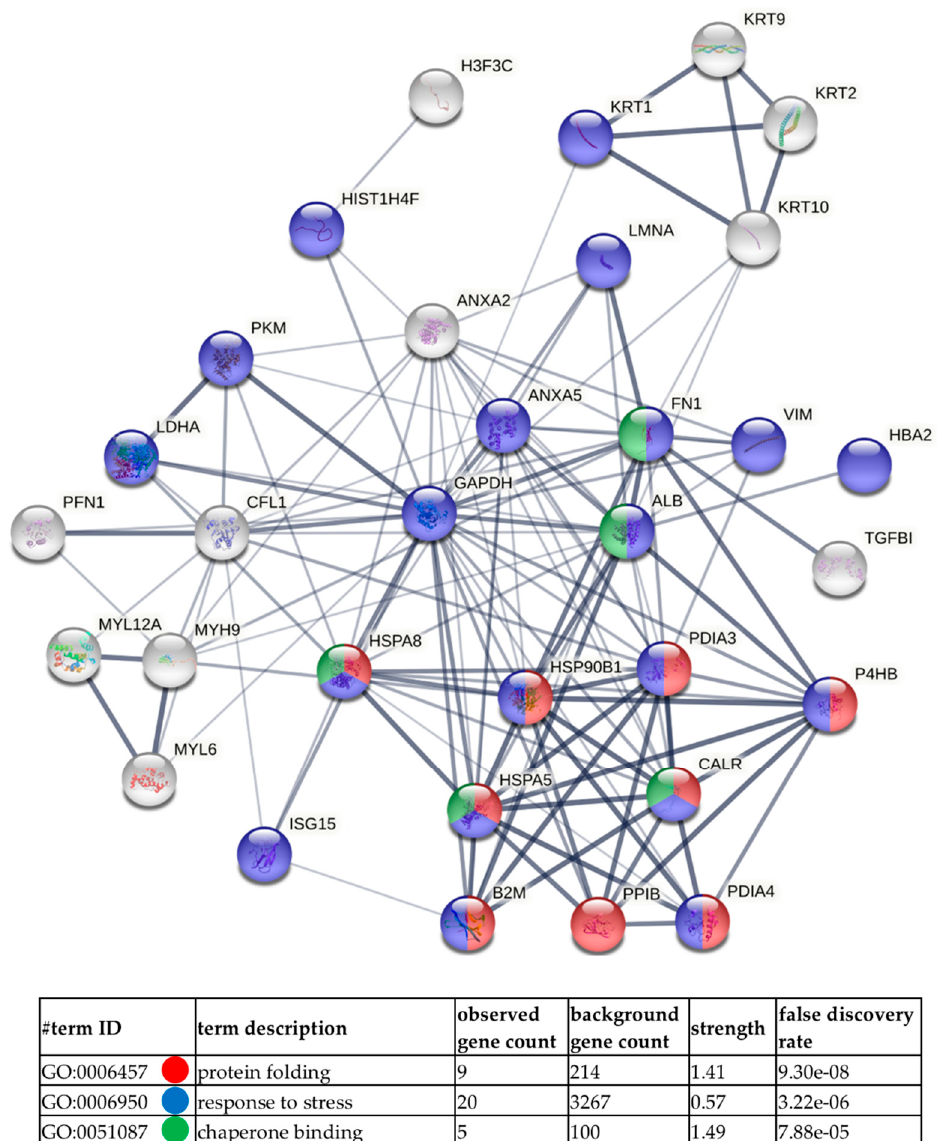
Figure 7. Diagram of functional protein association networks prepared with the use of STRING v. 11.0 software for 10% of the most abundant proteins identified in HCV-29-derived ectosomes (i.e., 33 proteins). The selected strongly represented pathways are presented on interactome. Complete results, including proteins that were not identified in all biological/technical replicates, are provided in Supplementary Data S3.